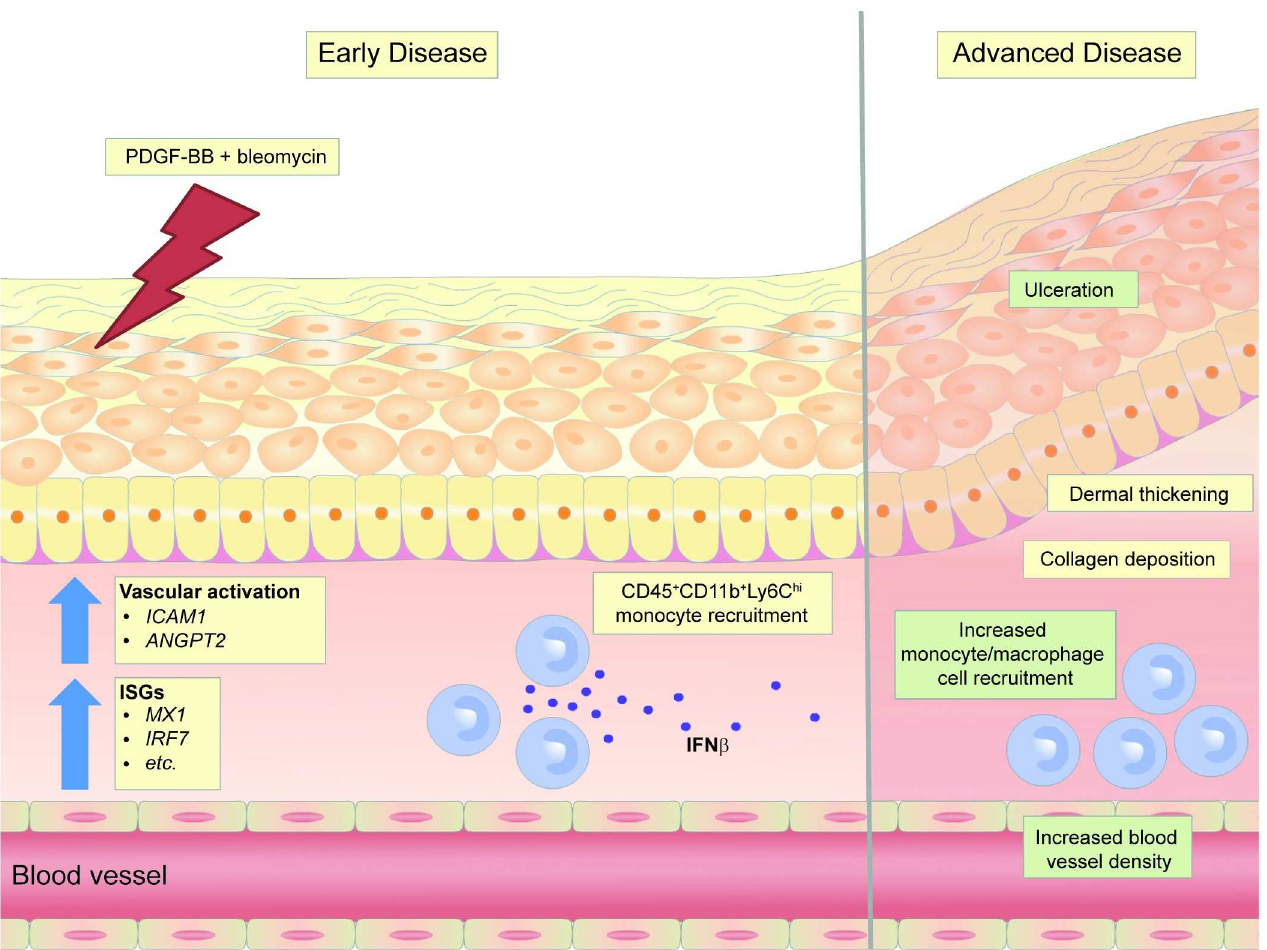
Fig 5. Modelof chronic activationof PDGFR β in a modelof skin fibrosis. Chronicactivation of PDGFR β in a model of skin fibrosis promotes vascular activation ( ICAM1 and ANGPT2 )and Type I IFN-dependent inflammatoryresponse (ISGs).PDGFR β activation significantly increases the numbersof IFN β -producing inflammatorymonocytes recruitedto the tissue. PDGF-BB-dependentfunctionsof tissue injury, blood vessel maintenance, and monocyte/macrophagecell recruitment in the skin were found to be dependenton IFNAR signaling(highlightedin green) in this model of